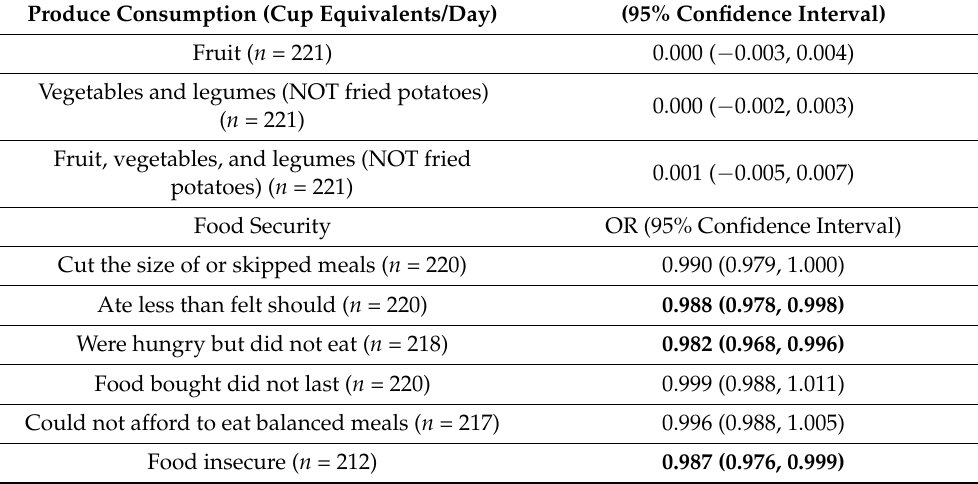
Table 3. Adjusted 1 beta coefficients and odds ratios estimated from regression models assessing the relationship between the estimated number of incentive dollars received in the past 30 days and daily produce consumption (in cup equivalents per day from NCI fruit and vegetable screener) and food security (from USDA 6-item screener) in the California Nutrition Incentive Program evaluation